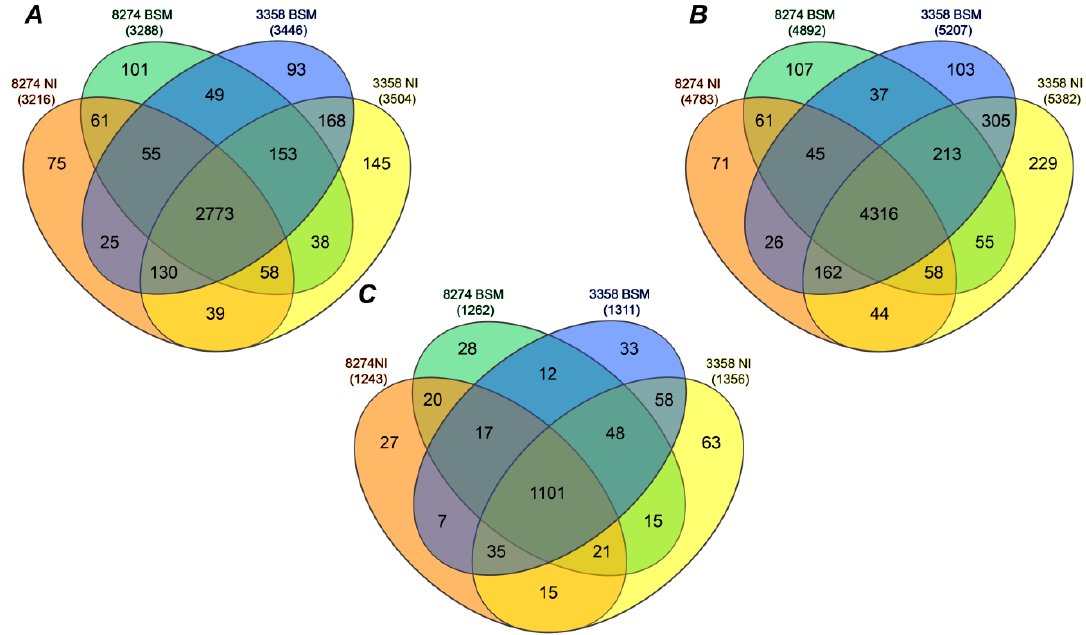
Figure 2. The numbers of tryptic peptides ( A ), possible proteins ( B ), and non-redundant proteins (protein groups, C ) identified in seeds of pea ( P. sativum L) plants, lines K-8274 (high efficiency of interaction with soil microorganisms (EIBSM), A ) and K-3358 (low EIBSM, B ), grown with (BSM, beneficial soil microorganisms) and without (NI, not inoculated) simultaneous colonization of pea roots with rhizobia and arbuscular mycorrhizae (AM) fungi R. irregularis . The pea seed protein tryptic digests ( n = 3) were analyzed by nano-high performance liquid chromatography-electrospray ionization mass spectrometry (nanoHPLC-ESI-Q-Orbitrap-MS) in DDA mode